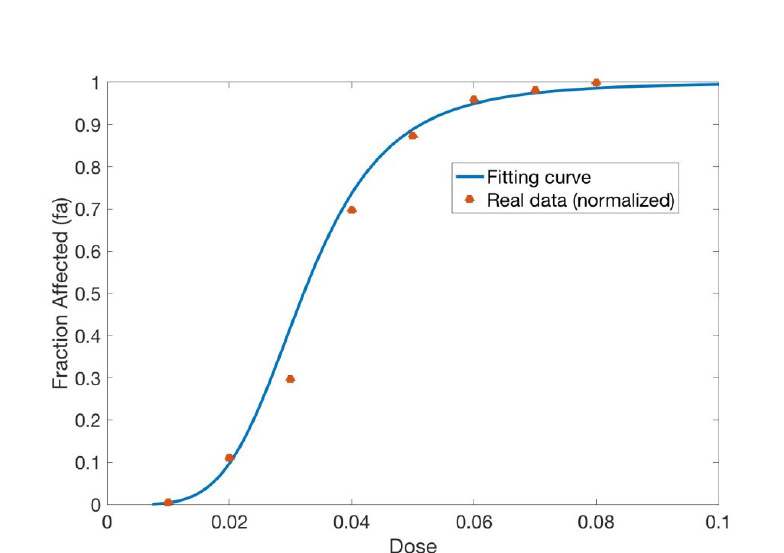
FIGURE 3 - The dose-effect curve of